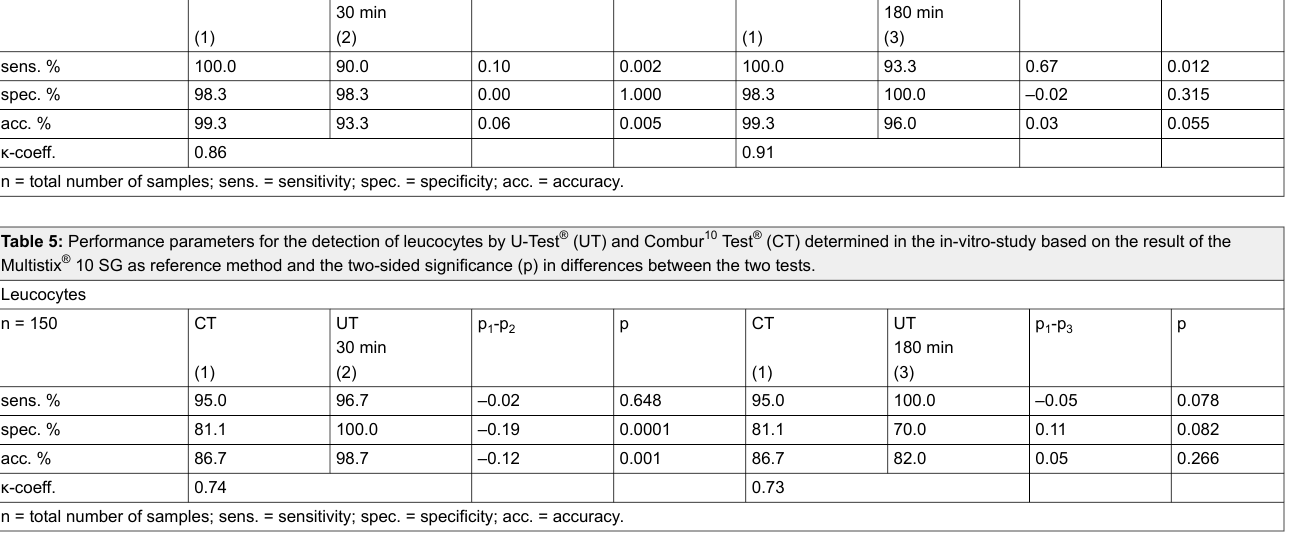
Table 4: Performance parameters for the detection of nitrite by U-Test ® (UT) and Combur 10 Test ® (CT) determined in the in-vitro study based on the result of the Multistix ® 10 SG as reference method and the two-sided significance (p) in differences between the two tests. Nitrite n = 150